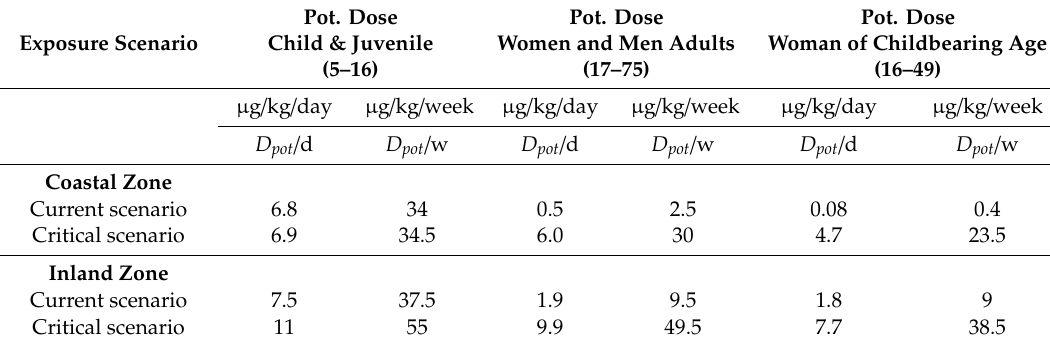
Table 4. Potential dose ( D pot ) and toxicological risk quotient (QR) of total mercury for both exposure scenarios in coastal and inland